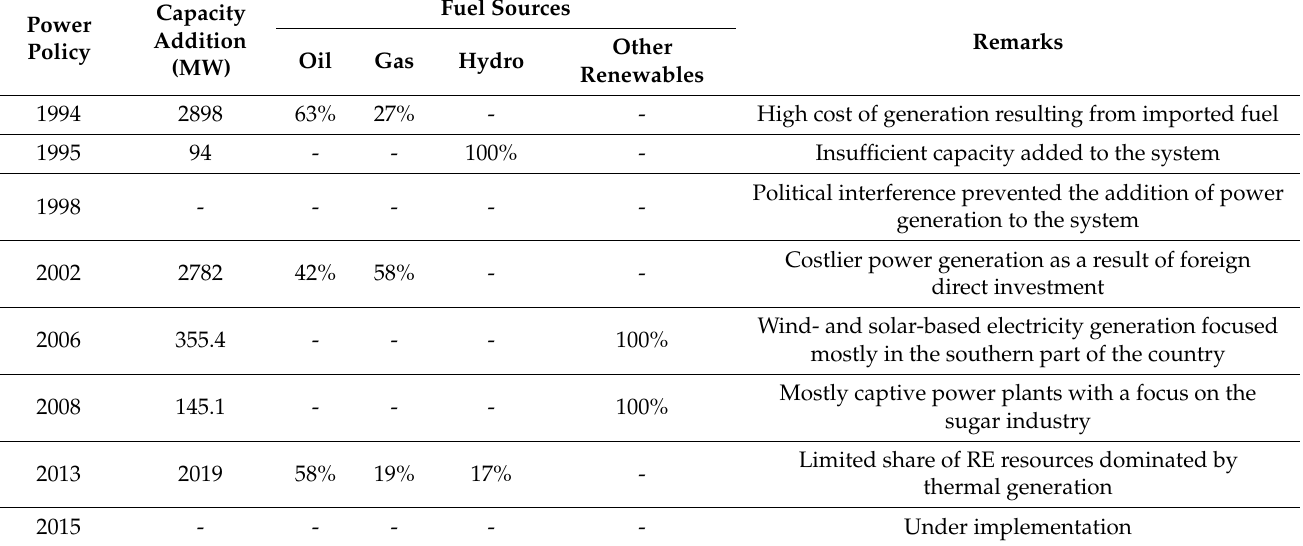
Table 5. Statistics on various energy policies of